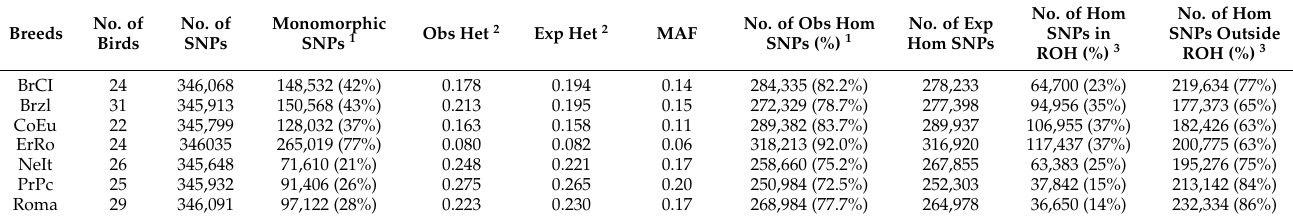
Table 1. Breeds’ descriptive statistics for monomorphic SNP count and proportion (%), observed (Obs Het) and expected (Exp Het) heterozygosity, minor allele frequencies (MAF), observed (Obs Hom) and expected (Exp Hom) number of homozygous SNPs, and number of Hom SNPs defining ROH and outside of ROH. Breeds No. of Birds No. of